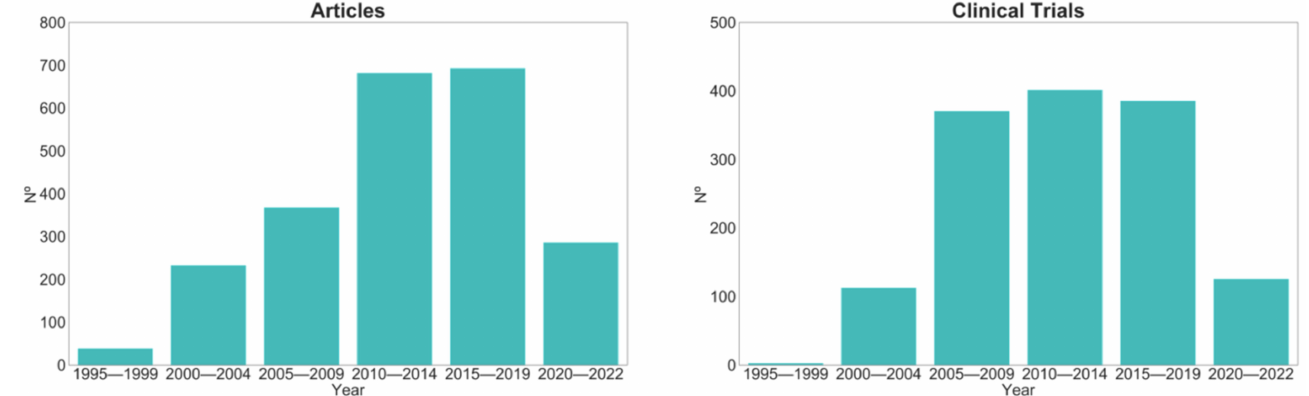
Figure 2. Articles published from 1995 reported on PubMed, entering the search terms “proteasome inhibitors” and “resistance” in all fields, and clinical trials whose intervention/treatment includes PIs (bortezomib, carfilzomib, ixazomib, marizomib, delanzomib or oprozomib) starting from 1995. Adapted from: ClinicalTrials.gov (https://clinicaltrials.gov/ct2/home accessed on 22 February 2022) and PubMed (https://pubmed.ncbi.nlm.nih.gov/ accessed on 22 February